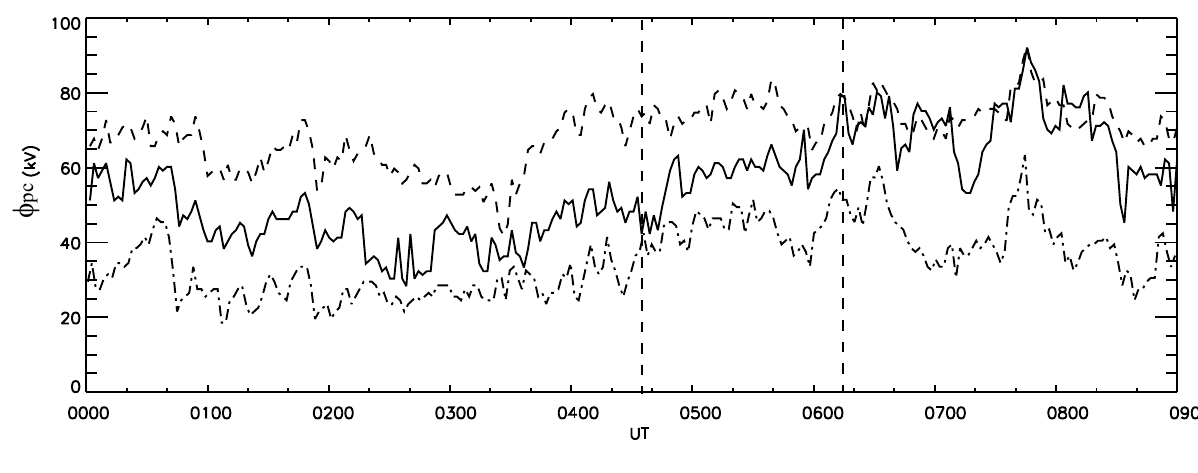
Fig. 11. The cross polar-cap potential estimated by the map-potential technique for the interval 16 Sept. 1998, 00:00–09:00UT, IMF information was given by the WIND satellite (black line). Overlaid is the cross polar-cap potential assuming constant B z negative (dashed line), and B z positive (dot-dashed